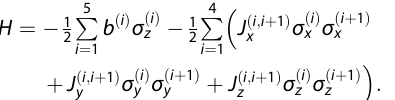
J ð i ; j Þ J ð i ; j Þ 2 π ´ 1 kHz . The "effective x ¼ y ¼ z ¼